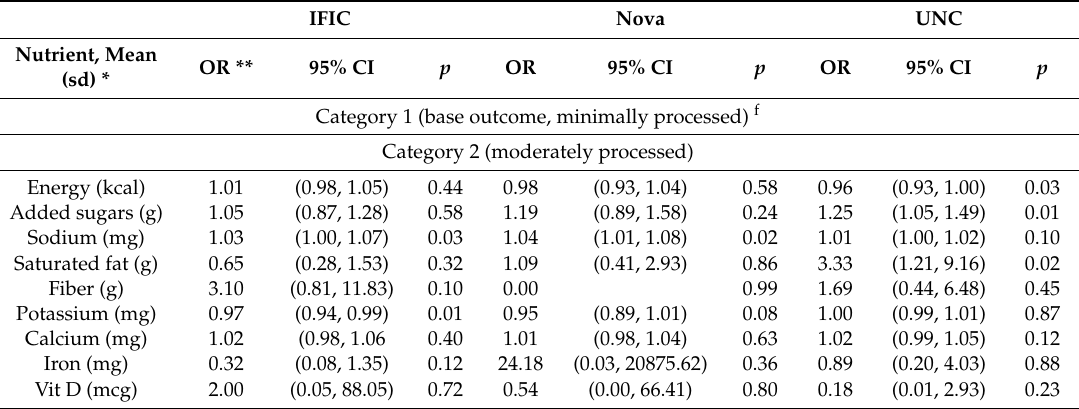
Table 3. Multinomial logistic regression results for the association between classification category as determined by the IFIC a,15 , Nova 14 , and UNC b,13 processing classification systems and concentration of nutrients of concern c among the top 100 foods most commonly consumed among 6–12-year-olds in the U.S. population d , NHANES e